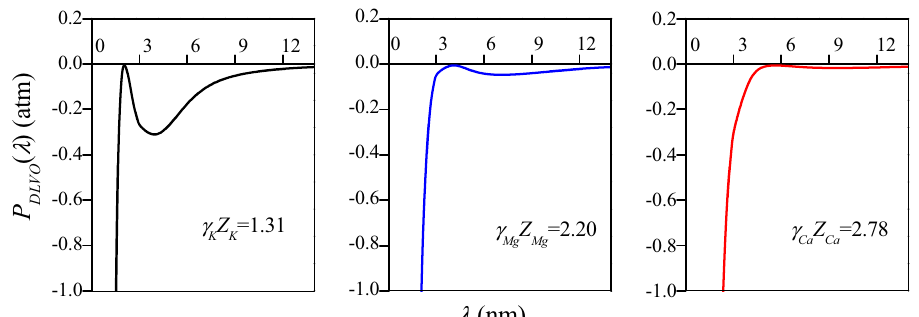
Figure 10. The modified P DLVO ( λ ) at CCCs of K + , Mg 2+ and Ca 2+ , where curves in different colors represent the different cation systems; the areas of closed curves P DLVO ( λ ) versus λ were utilized to estimate the energy barrier and Δ W = 0 kT at f 0 = CCC K = 134.30, CCC Mg = 13.27 and CCC Ca = 4.19 mmol L −1 ,